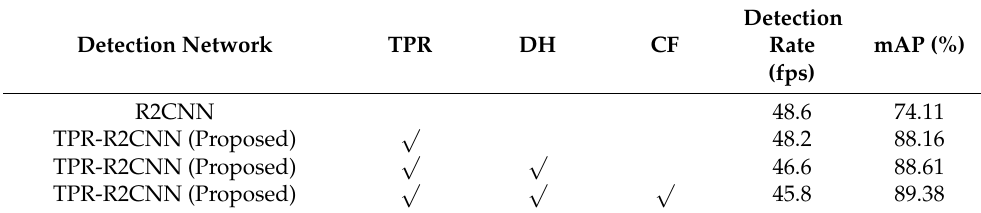
Table 3. Comparison of detection rate and mAP on HRSC2016 dataset. TPR: Three-point regression; DH: double detection head; CF: classification